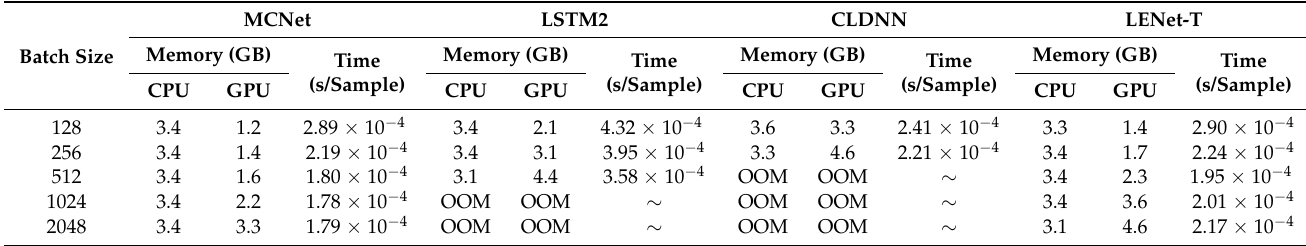
Table 11. The effect of different batch sizes on inference speed on the P2